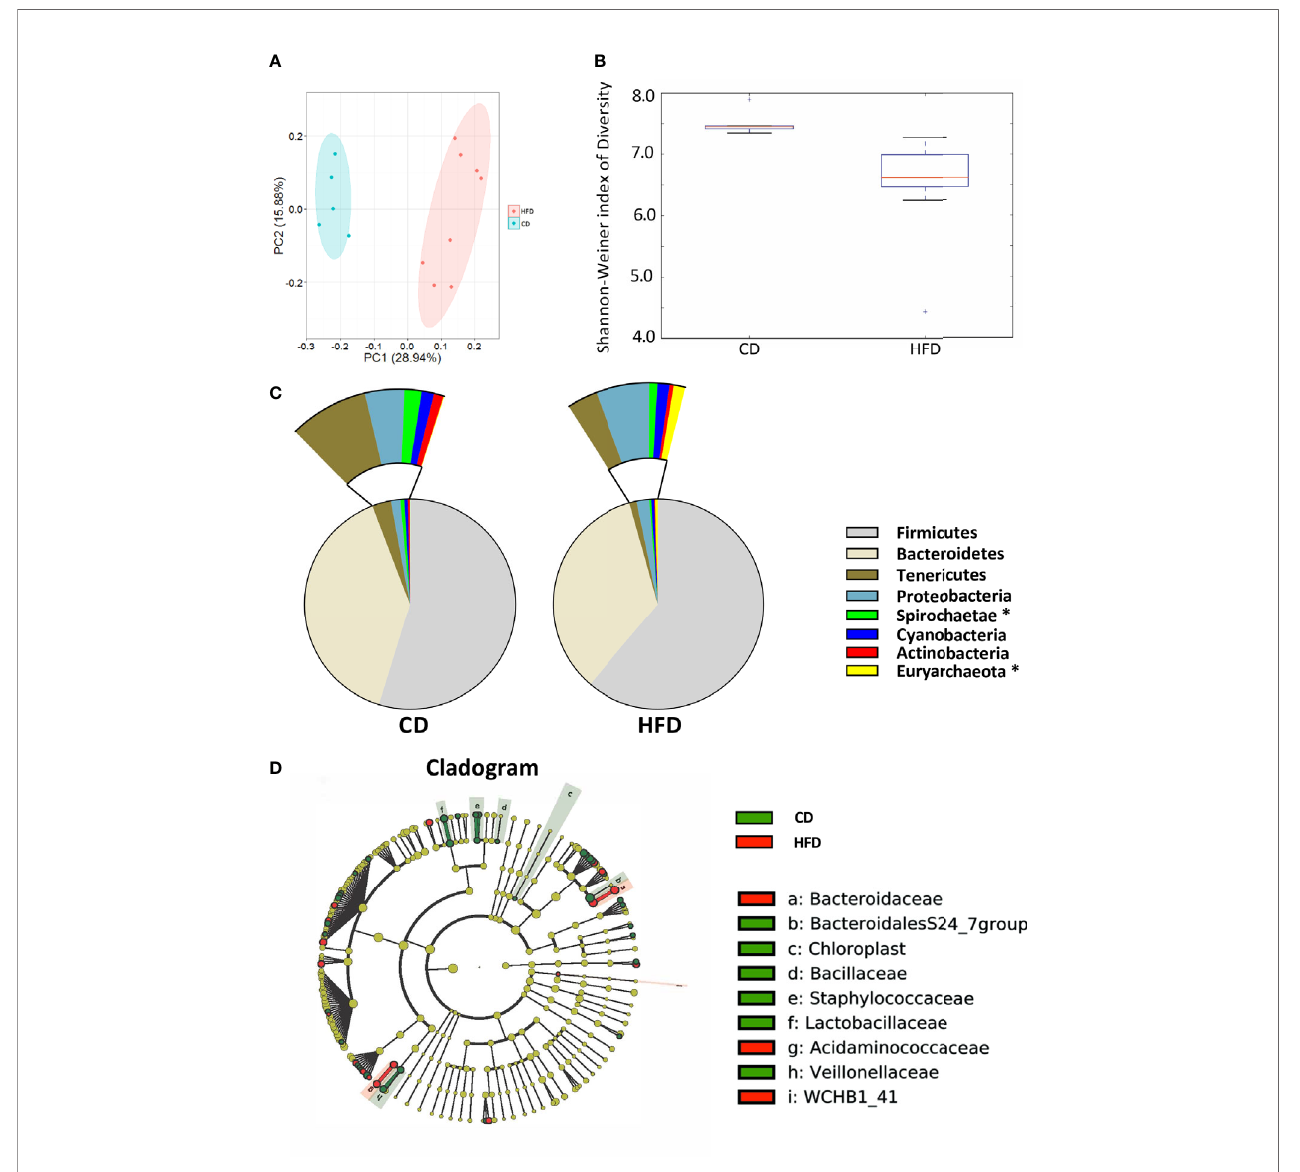
FIGURE 2 | Bacterial 16S rRNA-based analysis of the intestinal microbiota of CD- and HFD-fed rats. (A) PCoA plot showing the unweighted UniFrac distance between CD- and HFD-fed rats. Each rat is identi fi ed by a point. (B) Shannon-Weiner index representing the alpha-diversity in CD- and HFD-fed rats. (C) Pie charts showing the relative abundance of phyla in the fecal microbiota of CD and HFD-fed rats (Kruskall Wallis test). (D) Cladogram showing the taxa most differentially associated with CD- (green) or HFD-fed (red) rats (Wilcoxon rank-sum test). Circle sizes in the cladogram plot are proportional to bacterial abundance. The circles represent, going from the inner circle to the outer circle: phyla, class, order, family and genus. CD, n=6; HFD, n=8 CD, Control diet; HFD, High fat diet; OTU, operational taxonomic